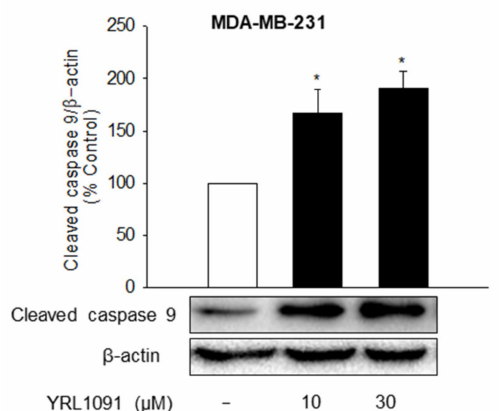
Figure 5. Effect of YRL1091 on the activation of caspase 9 in MDA-MB-231 cells. Cells were treated with YRL1091 at 10 and 30 µ M for 24 h. The level of cleaved caspase 9 was measured by western blotting. Each data point was calculated as the percentage of protein level in vehicle-treated control cells. Representative bands from at least three independent experiments were shown. * p < 0.05